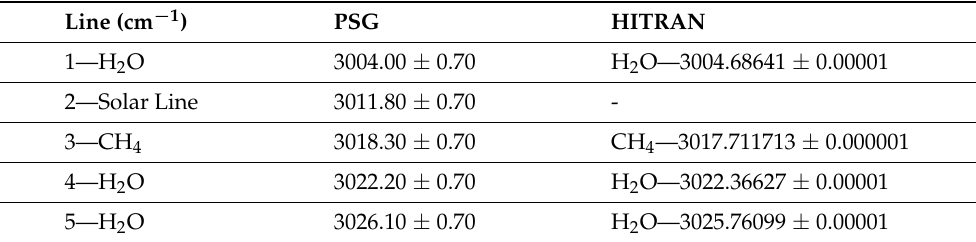
Figure 14. Identification of CH 4 and H 2 O absorption features in MEx simulations—Mars. ( Left panel ): Effect of the variation of methane abundance in the model on the resulting radiance for CH 4 = 0 ppb (blue), 13 ppb (orange), 18 ppb (green) and 30 ppb (red). A methane absorption feature was identified. ( Right panel ) Effect of the variation of H 2 O in the model in the resulting radiance, for H 2 O = 1 (blue, standard abundance of H 2 O in the model), H 2 O = 3 (orange), H 2 O = 5 (green) and H 2 O = 7 (red). Three H 2 O absorption features were identified. The position of the absorption features agrees with the positions in HITRAN [56] (see Table 4). Table 4. Methane on Mars, MEx observations—comparison between the position of the absorption feature center in the simulation and the position of the strongest absorption line from the same species from HITRAN in a wavenumber range centered in the position of the absorption feature in the simulation. The position of the absorption features agrees with the positions from HITRAN